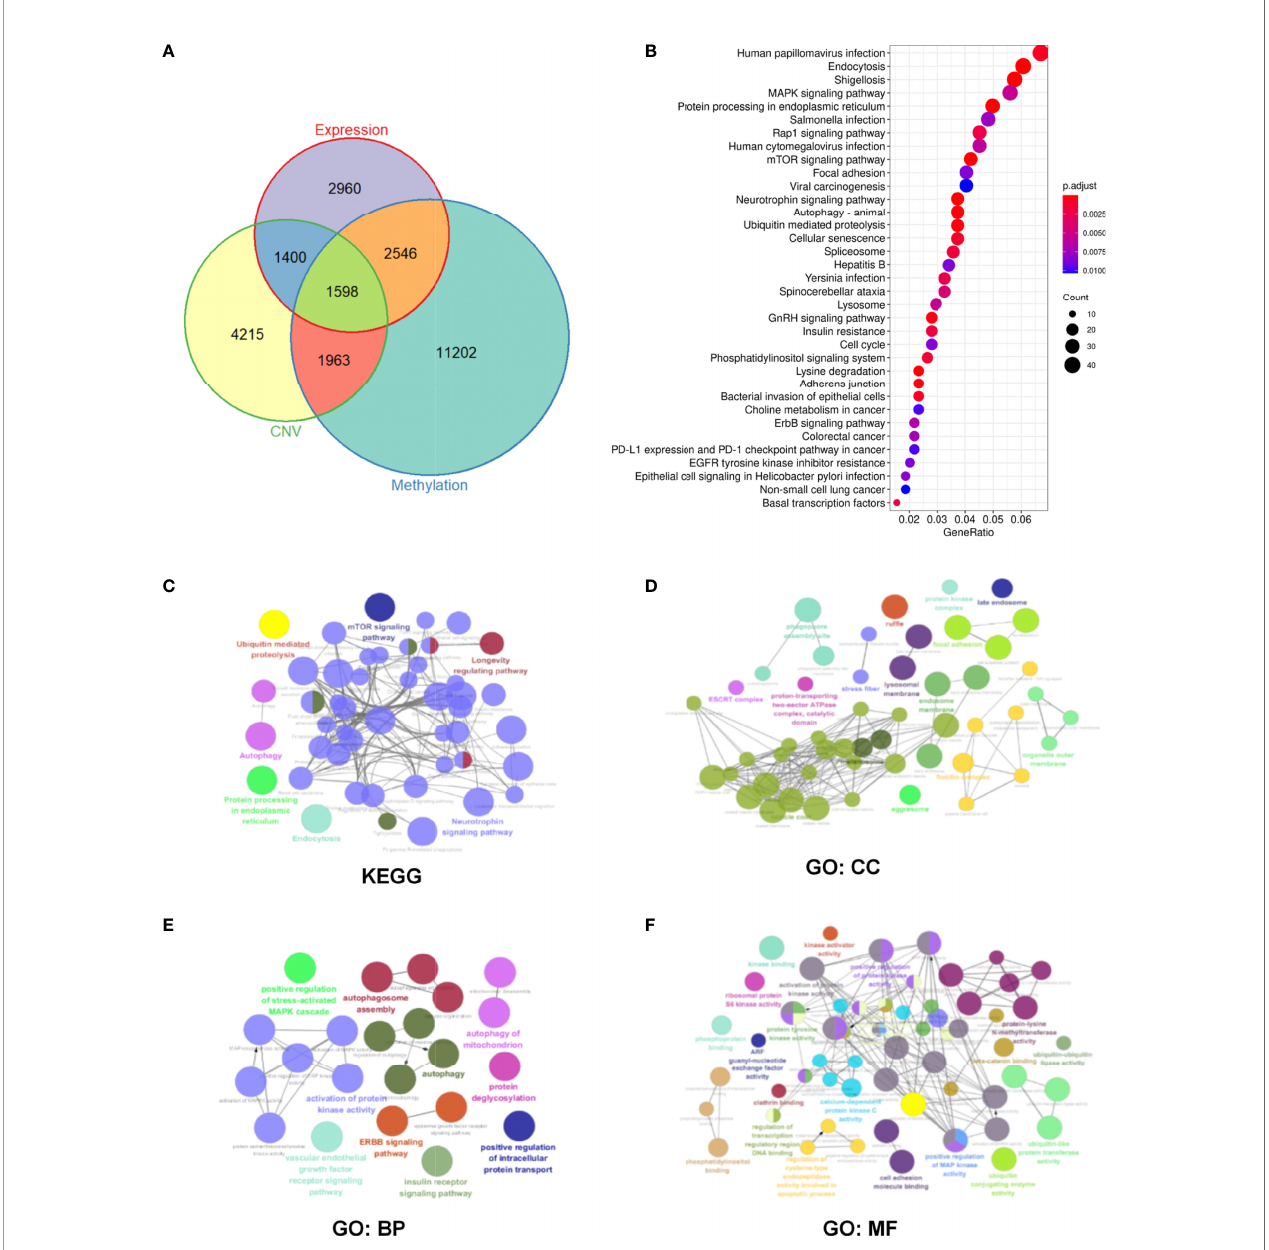
FIGURE 3 | Identi fi cation and enrichment pathway analysis of m6A regulator-related mRNAs in head and neck squamous cell carcinoma (HNSCC) patients. (A) Overlapped differentially expressed genes at CNV, methylation, and transcription levels. (B) Enrichment analysis of 1598 m6A regulator-related genes via the Kyoto Encyclopedia of Genes and Genomes (KEGG) pathway. (C – F) Signi fi cantly enriched KEGG and Gene Ontology (GO) pathways. Objects with the same color belong to the same group and have been depicted using the same color label on the side. GO analysis helped classify regulators into the biological process (BP), cellular component (CC), and molecular function (MF)